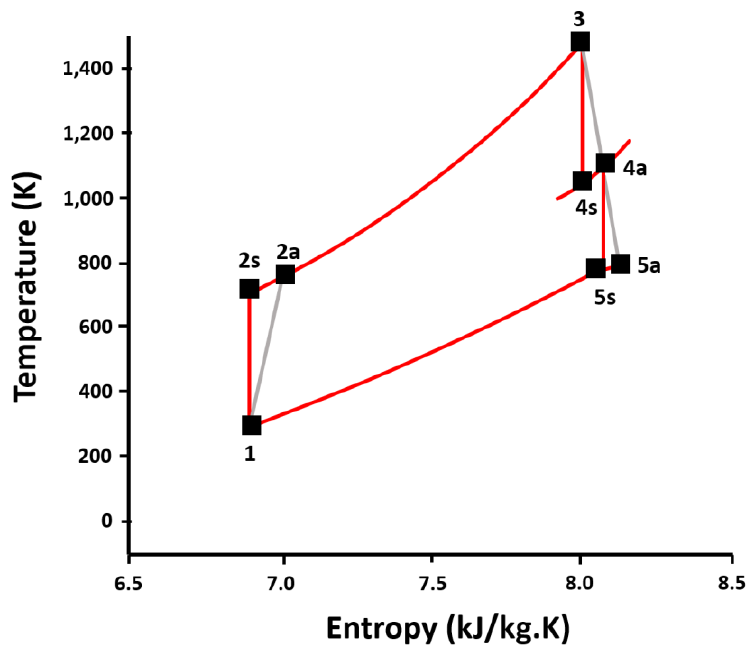
Figure 3. T-s diagram for the actual gas turbine cycle of the designed system.